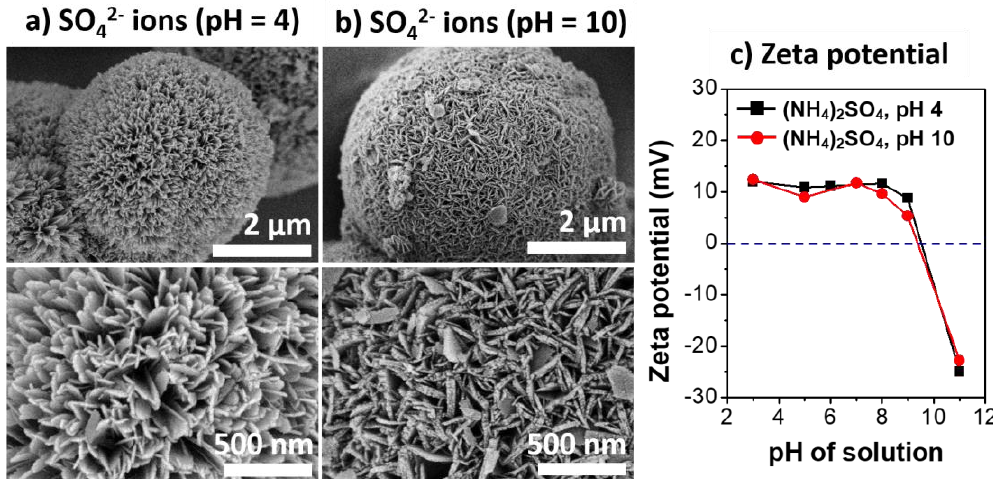
Figure 4. SEM micrographs of Al@AlOOH samples prepared by HTR in the aqueous solution of (NH 4 ) 2 SO 4 at pH of 4.0 ( a ) and 10.1 ( b ). The zeta potential of the Al@AlOOH measured at various solution pHs ( c ).